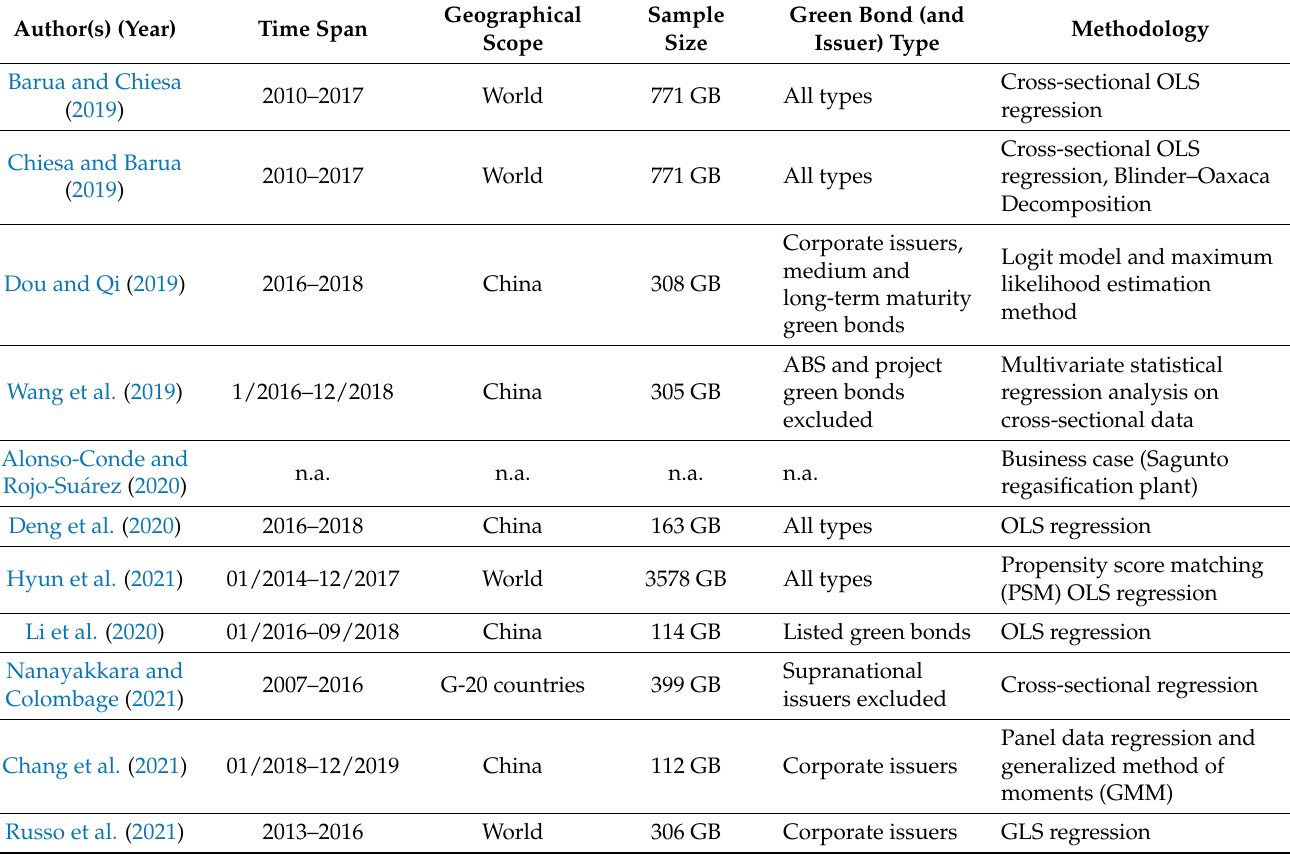
Table 8. “Green bond—supply-side analysis” empirical literature by the type of sample and